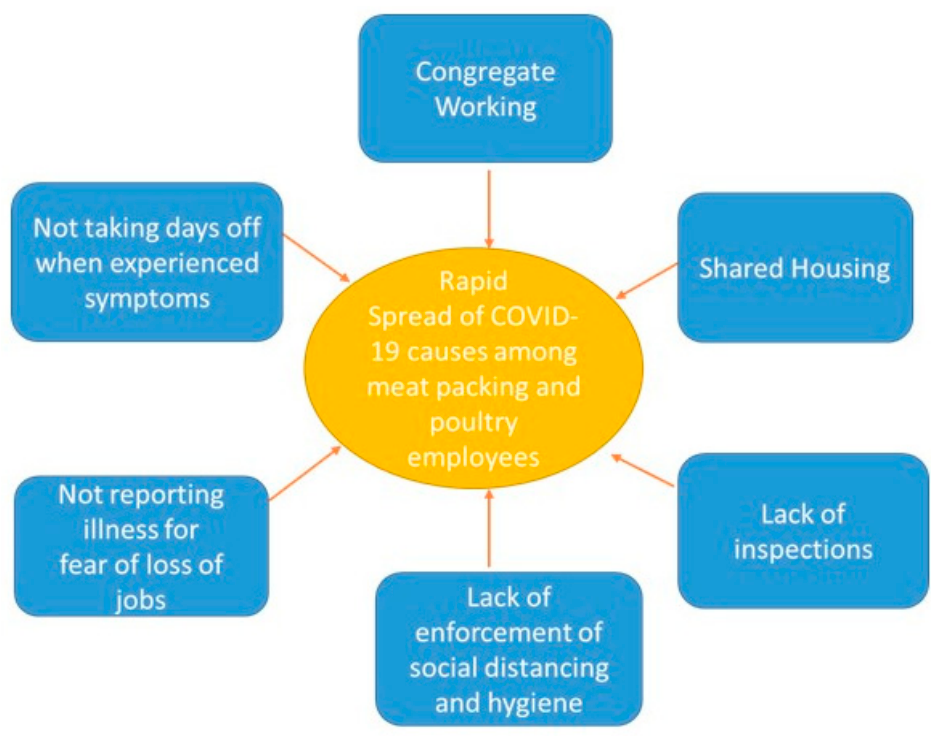
Figure 1. Rapid spread of COVID-19 among workers in meat and poultry processing facilities.